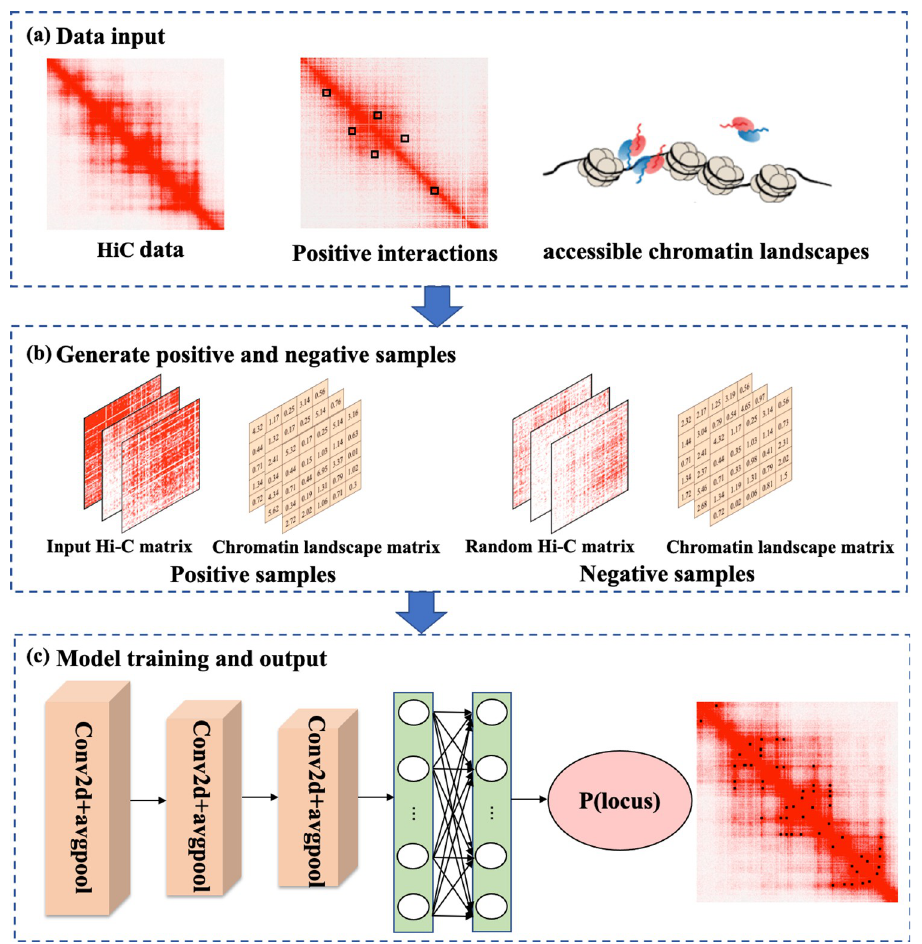
Fig 1. The workflow of DLoopCaller. (a) Data inputs includes Hi-C matrix, accessible chromatin landscapes, and enriched experimental data such as ChIA-PET/HiChIP and Capture Hi-C as positive interactions. (b) Positive samples are generated according to the input data, and negative samples are generated according to the similar distance or greater distance of the positive samples. (c) DLoopCaller includes three convolutional blocks, two fully connected layers and a classification layer, in which each block consists of a convolutional layer, a ReLU layer, a dropout layer, and followed by a global average pooling